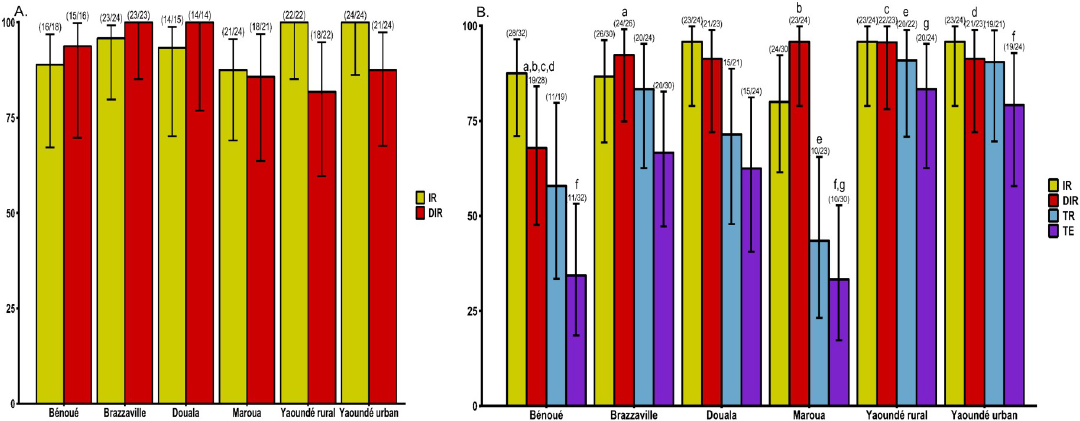
Fig 3. Infection, dissemination, transmission rates and transmission efficiency of Ae . aegypti from Central Africa. A) Infection and dissemination rates at 14 days post-exposure (dpe). B) Infection, dissemination, transmission rates and transmission efficiency at 21 dpe. Error bars show the 95% confidence interval. In brackets, the number of mosquitoes examined. IR: the proportion of mosquitoes with infected body among engorged mosquitoes; DIR: the proportion of mosquitoes with infected head among mosquitoes with infected body; TR: the proportion of mosquitoes with infectious saliva among mosquitoes with infected head. The lowercase letter on the top of some indices indicates the significant difference for pairwise comparisons. When the same letter is shared by several populations, this indicates that the difference is significant ( P < 0.05) between